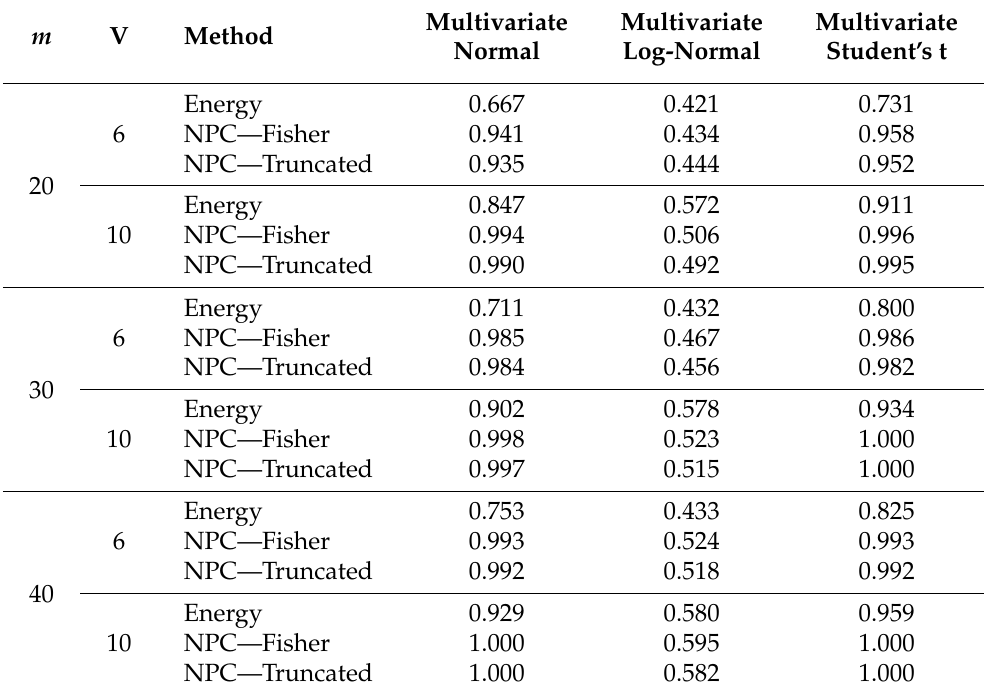
Table 3. Rejection rates with significance level α = 1% under the alternative hypothesis varying m